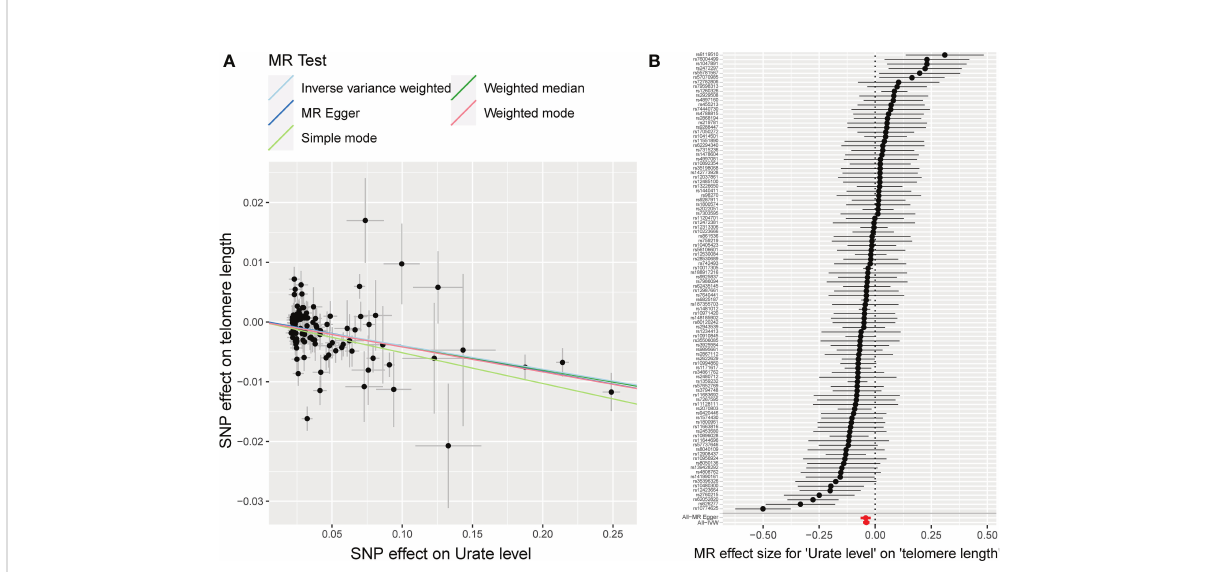
FIGURE 1 MR plots for the causal association of urate level on LTL. (A) Scatter plot of SNP effect on LTL against that on urate level. The slope of each fi tted line represents the combined effect using each MR analysis method. (B) Forest plot of effect from each SNP and pooled MR effect sizes for urate level on LTL. Each dot and its corresponding line represent the effect size and 95%CI. Each dot and its corresponding line represent the pooled estimates after the removal of the corresponding SNP. LTL, leukocyte telomere length; SNP, single nucleotide polymorphism; MR, mendelian